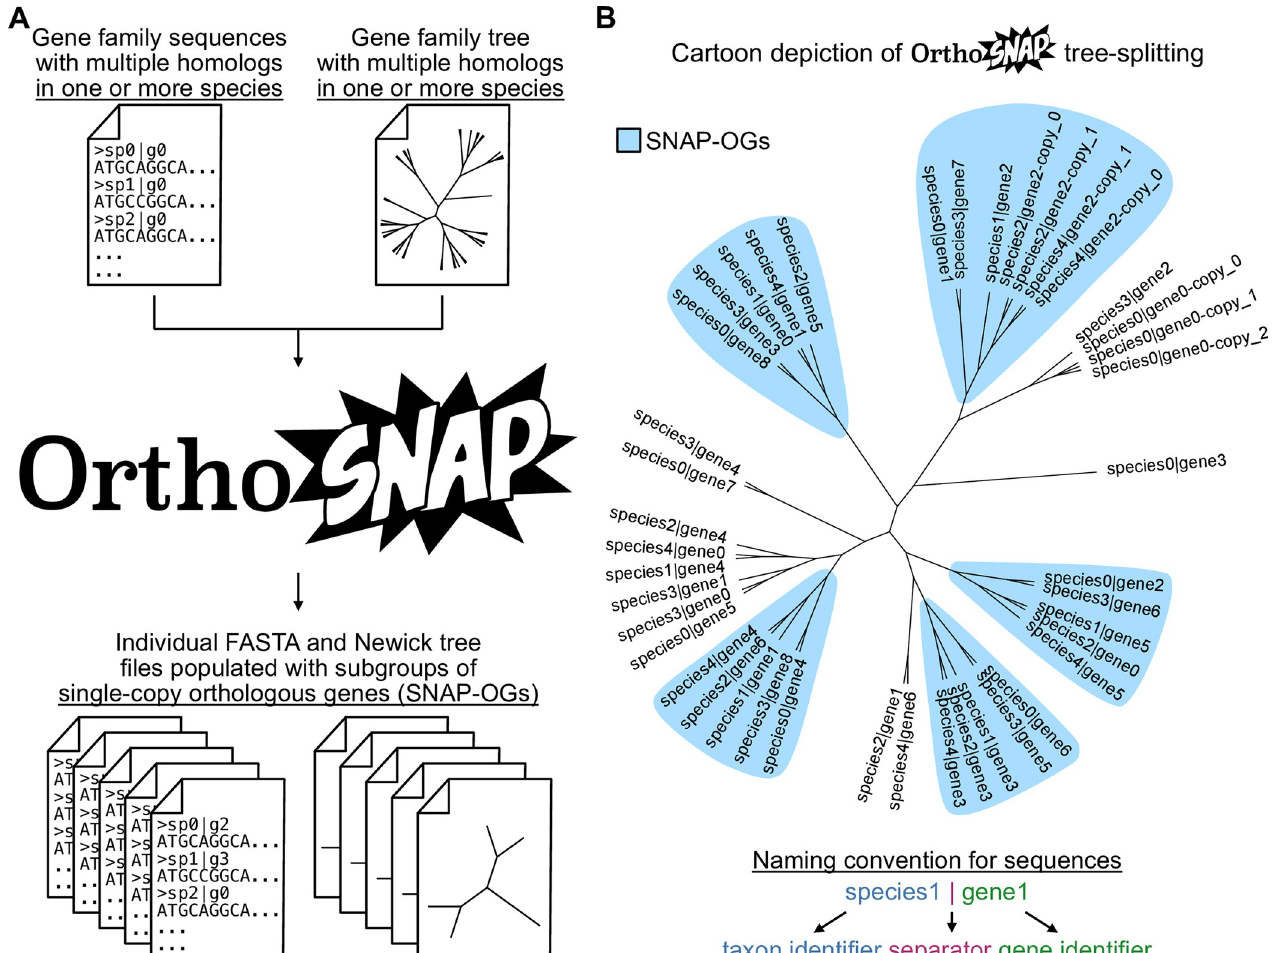
Fig 2. Cartoon depiction of OrthoSNAP workflow. ( A ) OrthoSNAP takes as input 2 files: a FASTA file of a gene family with multiple homologs observed in 1 or more species and the associated gene family tree. The outputted file(s) will be individual FASTA files of SNAP-OGs. Depending on user arguments, individual Newick tree files can also be outputted. ( B ) A cartoon phylogenetic tree that depicts the evolutionary history of a gene family and 5 SNAP-OGs therein. While identifying SNAP-OGs, OrthoSNAP also identifies and prunes species-specific inparalogs (e.g., species2|gene2-copy_0 and species2| gene2-copy_1), retaining only the inparalog with the longest sequence, a practice common in transcriptomics. Note, OrthoSNAP requires that sequence naming schemes must be the same in both sequences and follow the convention in which a species, strain, or organism identifier and gene identifier are separated by pipe (or vertical bar; “|”)